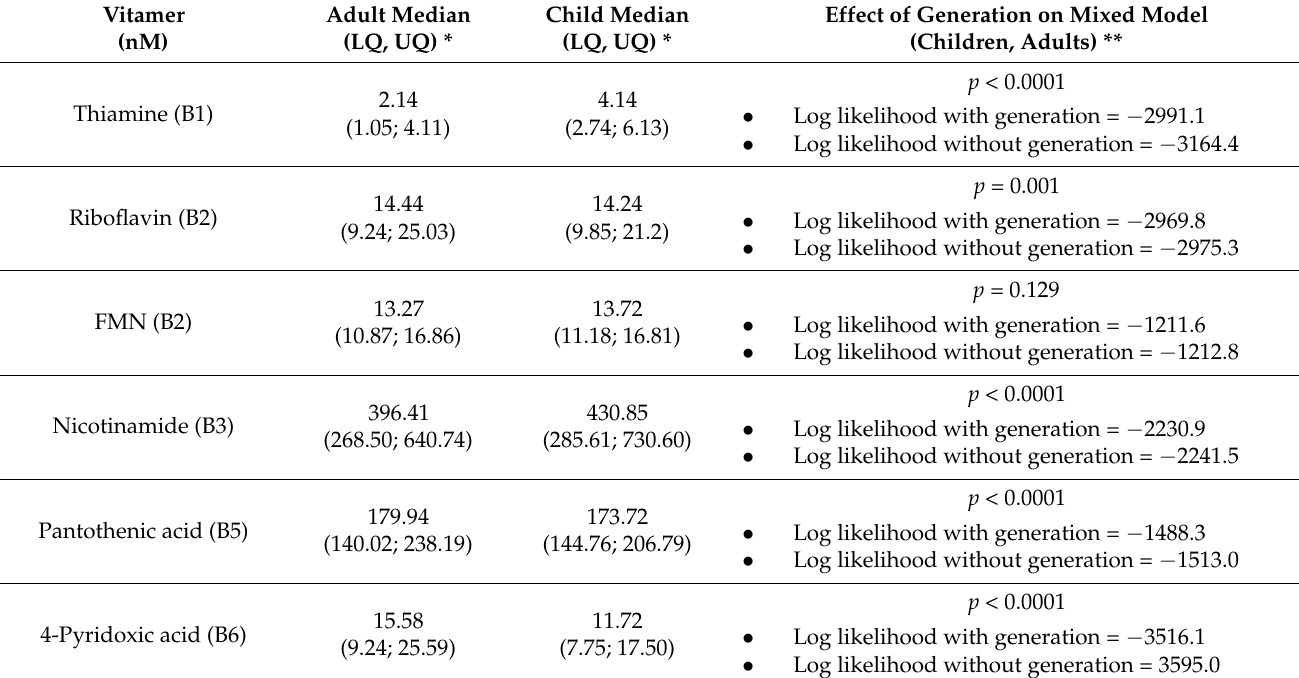
Table 3. Medians, Lower/Upper quartiles, and mixed model results of B vitamers in children and parents.